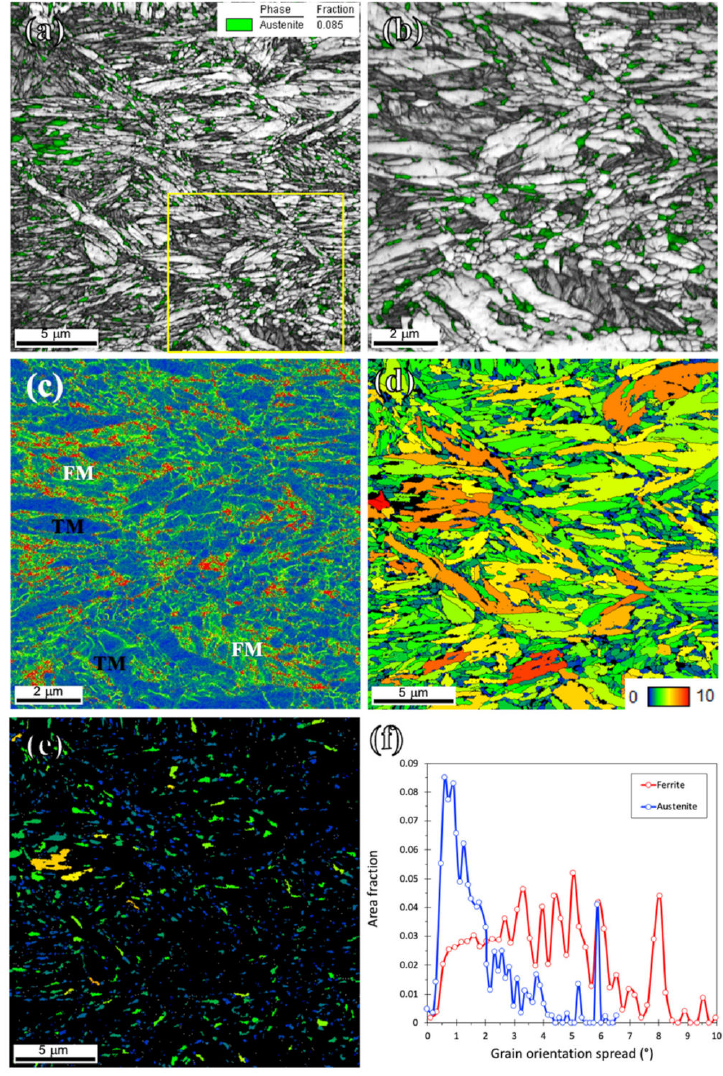
Figure 5. EBSD maps of the Def-A600 sample. ( a ) IQ map overlayed by phase map, ( b ) higher magnification of the marked area in ( a ), ( c ) KAM, ( d ) and ( e ) grain orientation spread (GOS) maps; and ( f ) GOS distribution for ferrite and